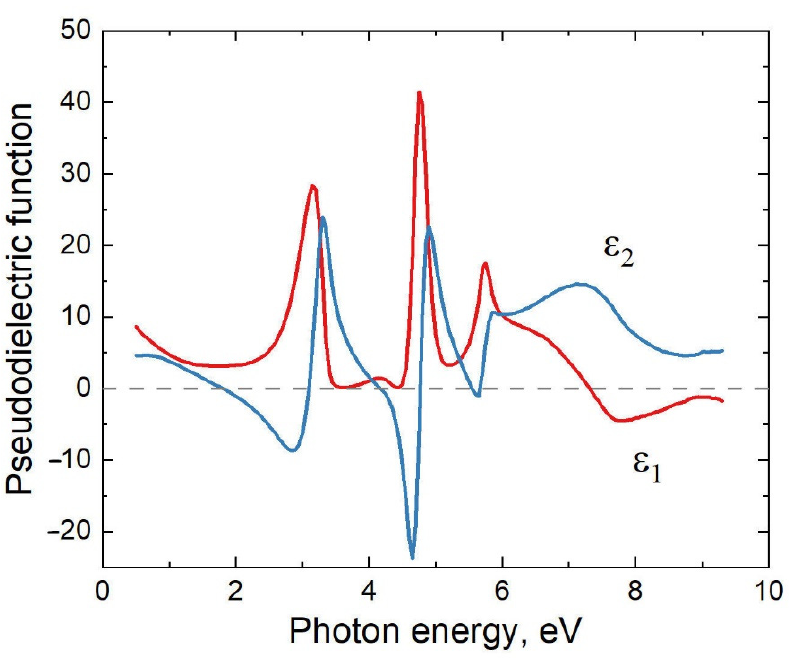
Figure 2. Pseudo-dielectric function of a 3C-SiC(111)/Si(111) hybrid substrate grown by the MCSA, measured by the VUV-VASE ellipsometer.